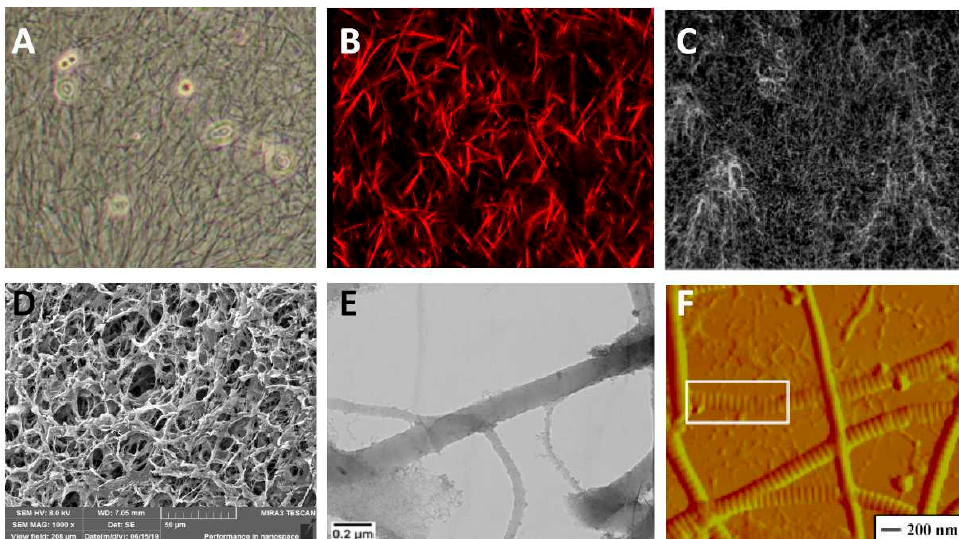
Figure 1. Several examples of collagen detecting methods. ( A ) light field of optical microscopy. ( B ) SHG imaging. ( C ) The reflection mode of confocal microscopy. Reprinted/adapted with permission from Ref. [3]. ( D ) SEM imaging. ( E ) TEM imaging. Reprinted/adapted with permission from Ref. [6]. ( F ) AFM imaging. Reprinted/adapted with permission from Ref. [12].